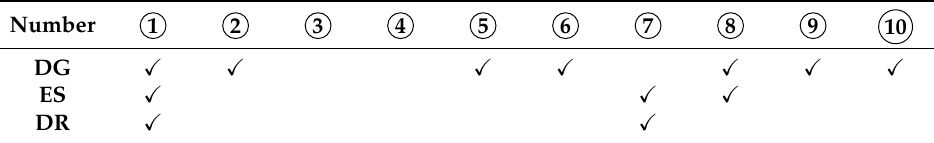
Table 5. Construction scheme of the comparison example.